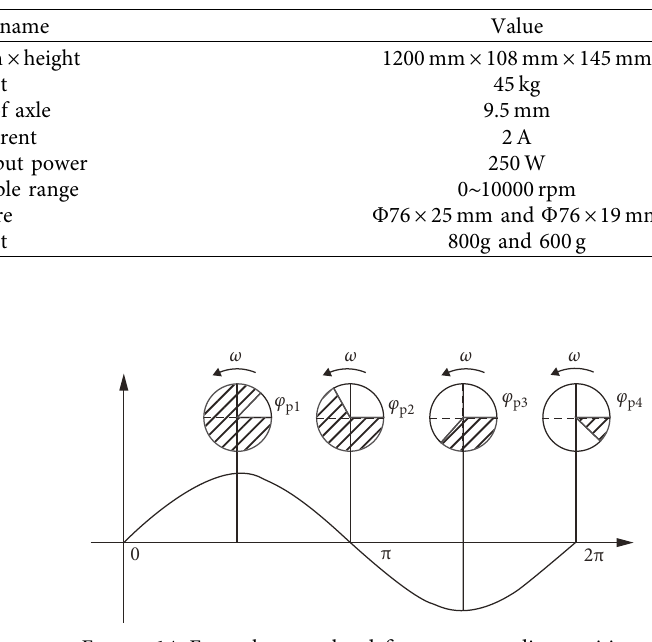
Table 4: Technical parameters of test bench components.